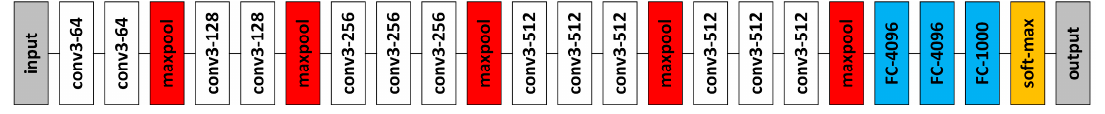
Figure 5. Architecture of the VGG-16 network.